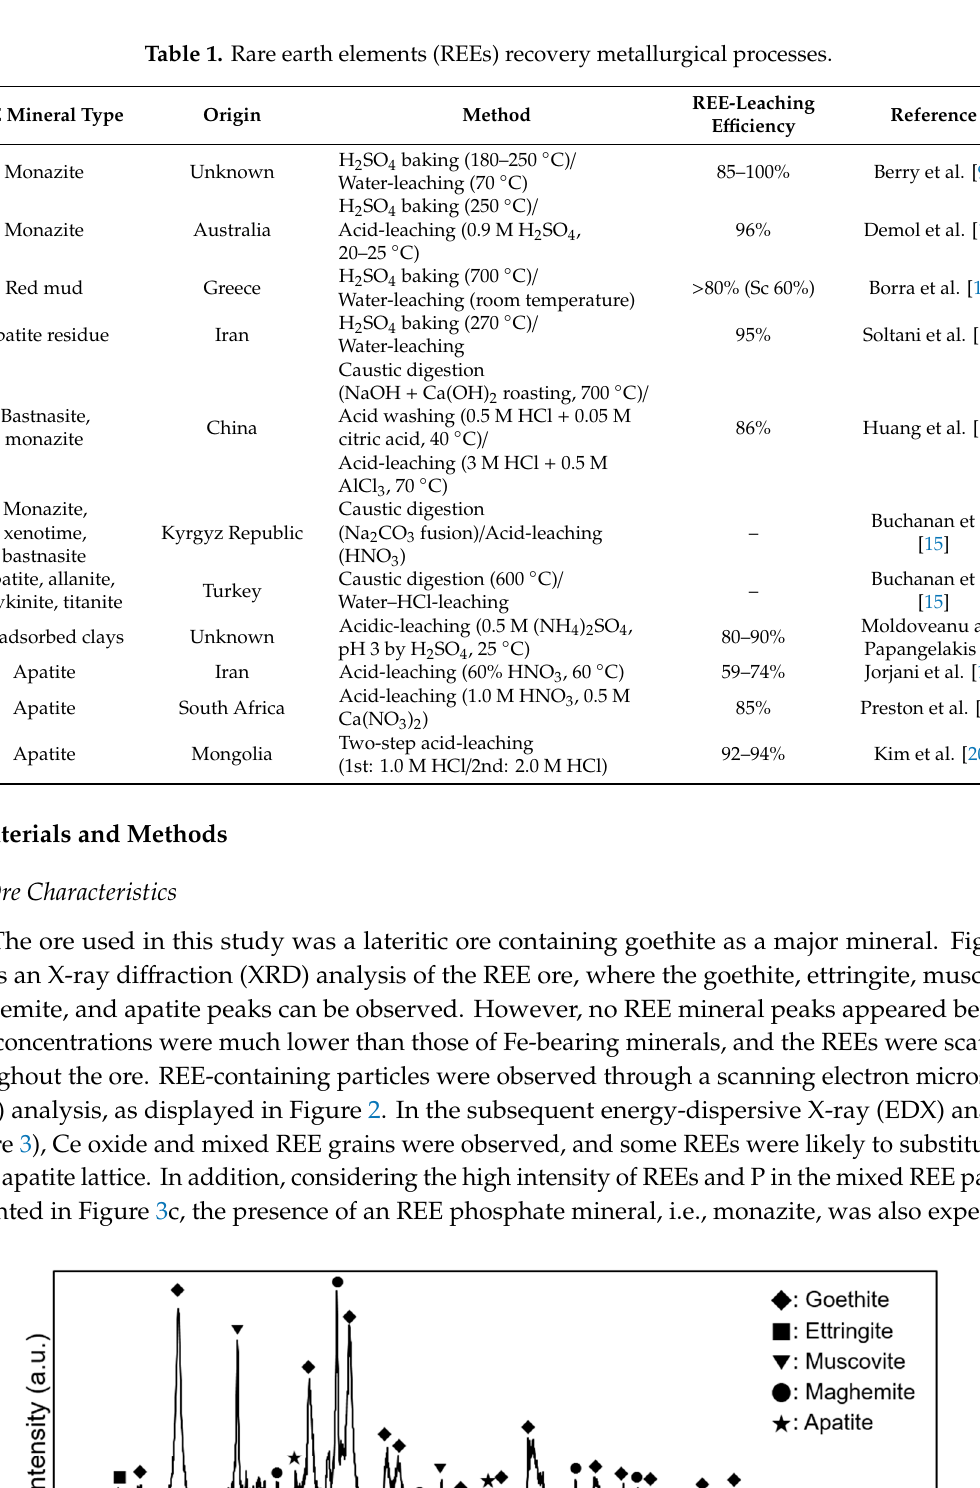
Figure 2. SEM image of the REE ore. Because the ore was lateritic, the iron content was significantly high (more than 50% as Fe 2 O 3 ) and 10% of manganese was present as an oxide as presented in Table 2. The TREO grade was 3.4%, which is relatively high as an REE ore. Ce was the most abundant element, followed by La, Nd and Y (Table 2). The ore was obtained as a ground material, and the 80% passing size was 30 µm (Figure 4).